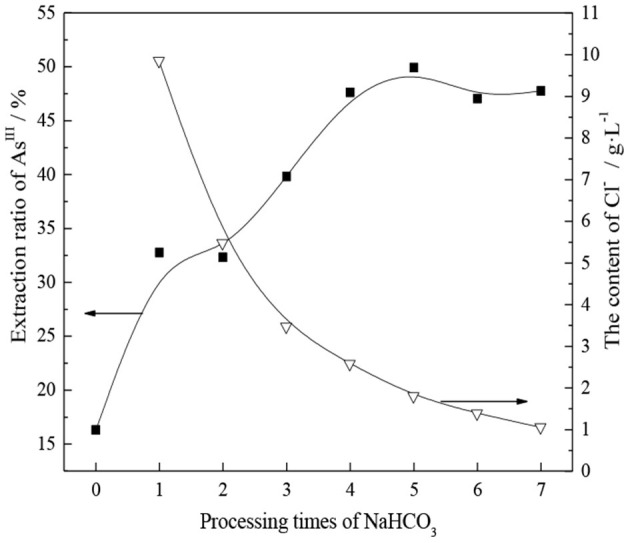
Relationship between the extraction rate of AsIII and the number of treatments with saturated NaHCO3.